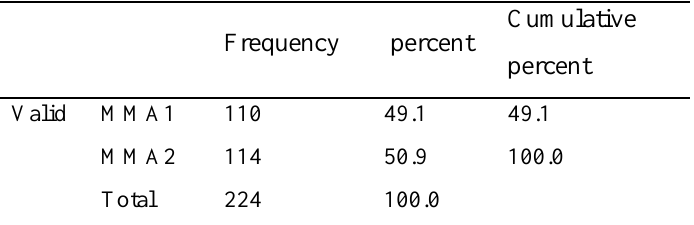
Table 4. Responses in Airport